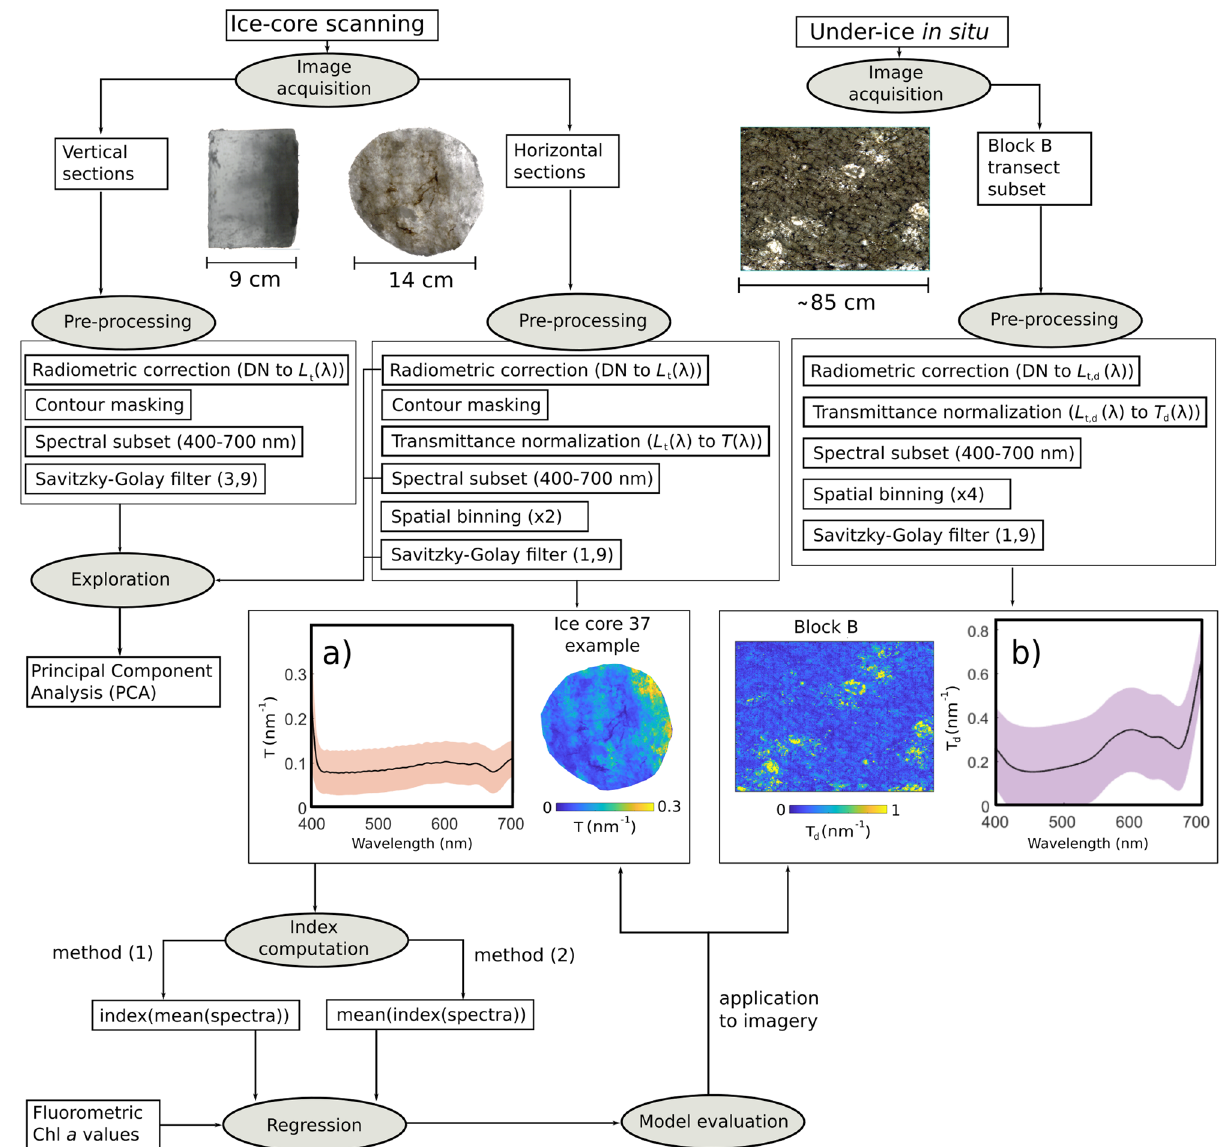
Figure 2. A flowchart of the data pre-processing workflow to yield pseudo-transmittance images and per- pixel biomass estimates from hyperspectral imagery of core sections and in situ. ( a ) and ( b ) display the mean ± standard deviation of directional transmittance at 668 nm through an example ice core (ice core 37) and the under-ice imagery, respectively. The under-ice HI procedure was detailed in a previous study 25 . L t (λ) refers to transmitted spectral radiance and T(λ) and T d (λ) to spectral transmittance and downwelling spectral transmittance, respectively. DN refers to Digital Number of raw imagery data. Savitzky–Golay filter numbers in parentheses refer to polynomial order and window length in bands, respectively. Two approaches are available to calculate a spectral index for each Sect. (1) from the mean transmittance spectrum of all pixels of the scanned core or (2) from each of the pixels spectrums in the pre-processed pixel of the core and then calculate the mean. Here method (2) was selected. Further information on method (1) can be found in supplementary